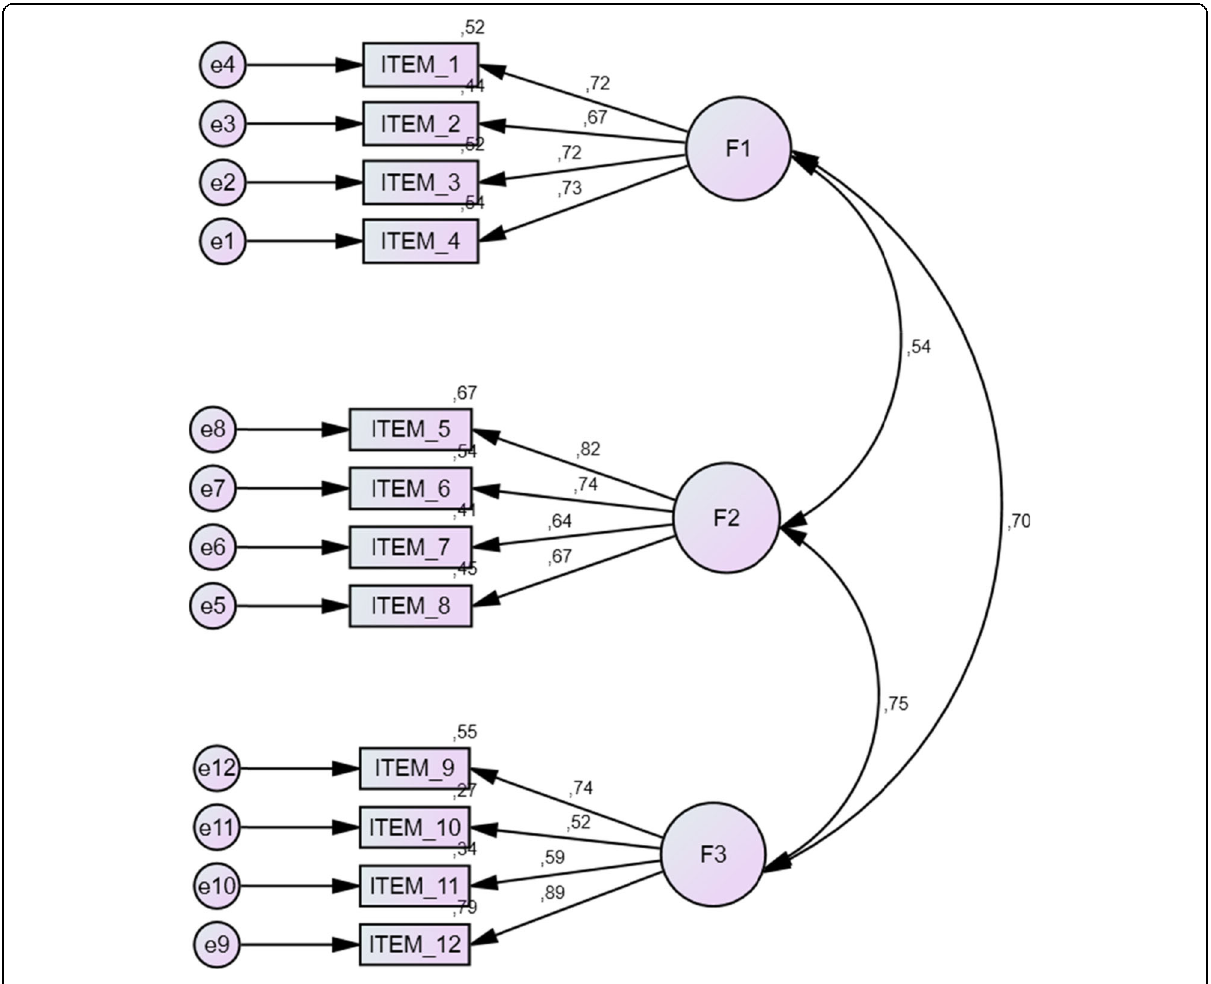
Fig. 1 Standardised solution of the CFA of the empathy